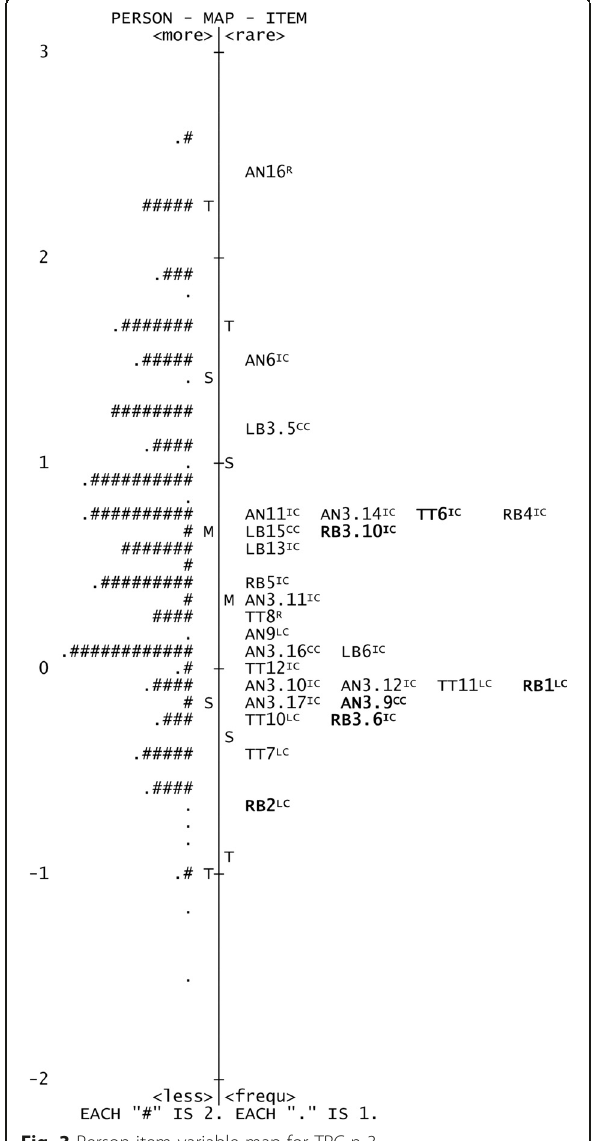
Fig. 3 Person-item variable map for